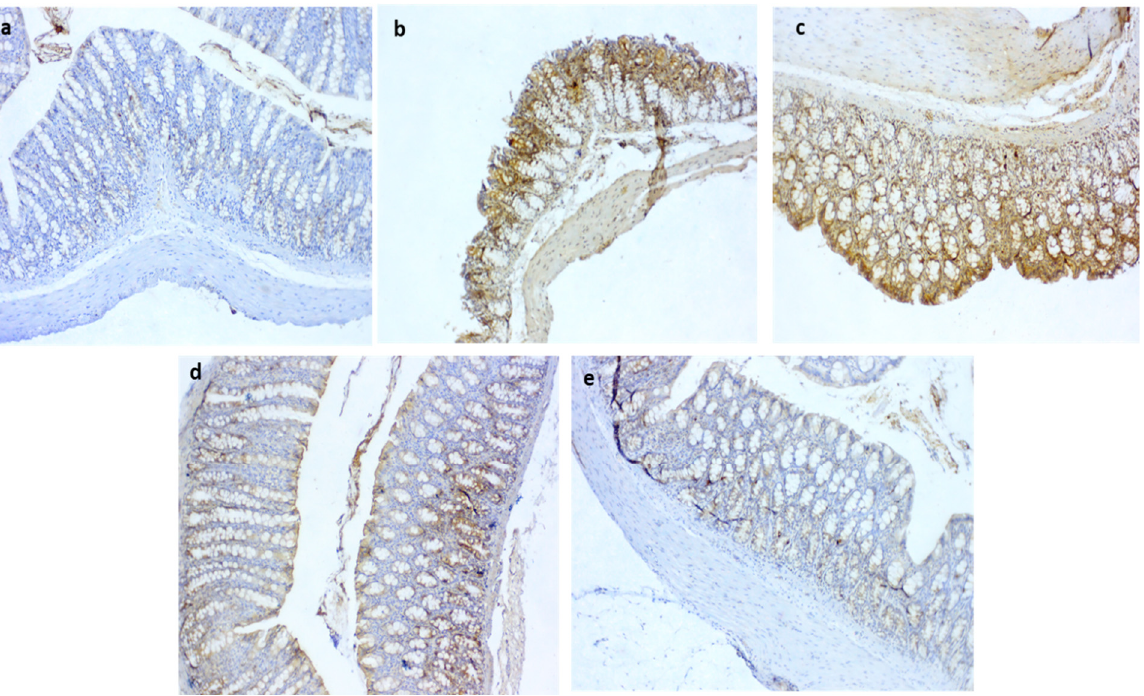
Figure 9. Photomicrographs of immunoreactivity for COX2 in colon sections showing ( a ) negative control with negative stained cells; ( b ) +ve group with markedly increased immunostaining of cells; ( c ) moderate COX2 expression in QT-NPsI group; ( d ) few numbers of immunolabelled cells for